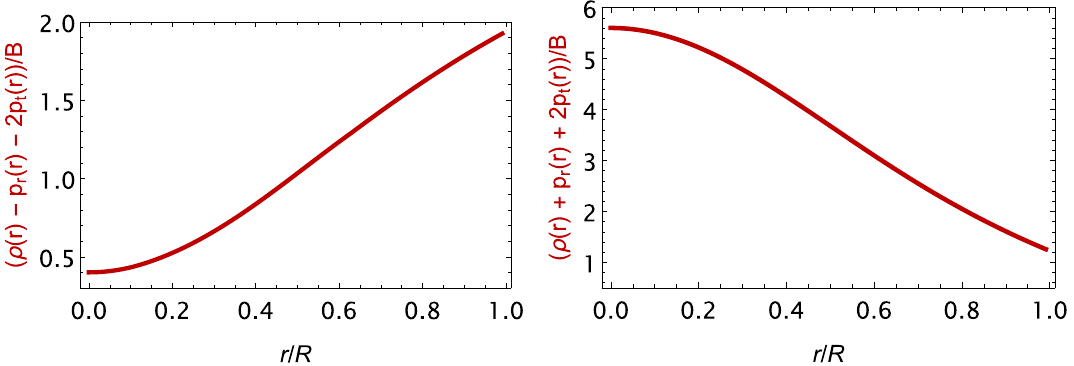
Fig. 3 Anisotropic DE stars within complexity factor: Energy conditions versus radial coordinate throughout the star